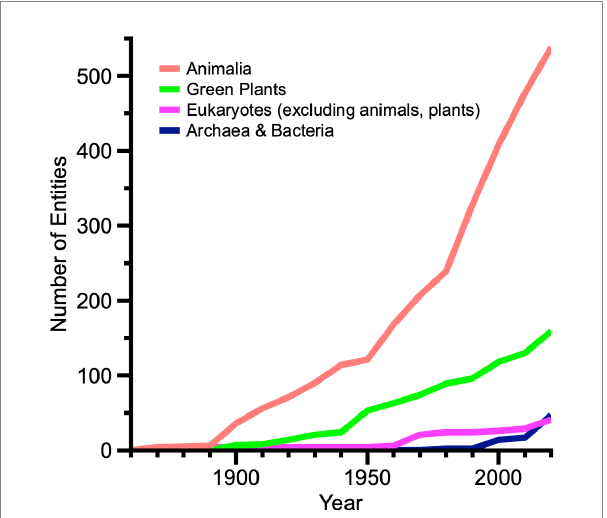
FIGURE 6 Line graph showing relative changes among 787 unique living fossil taxa among kingdoms of life from 1860 to 2020. Eukaryotes in this graph exclude green plants and animals. Taxonomic entity names are summed by decade, based upon earliest occurrences in our compilation.